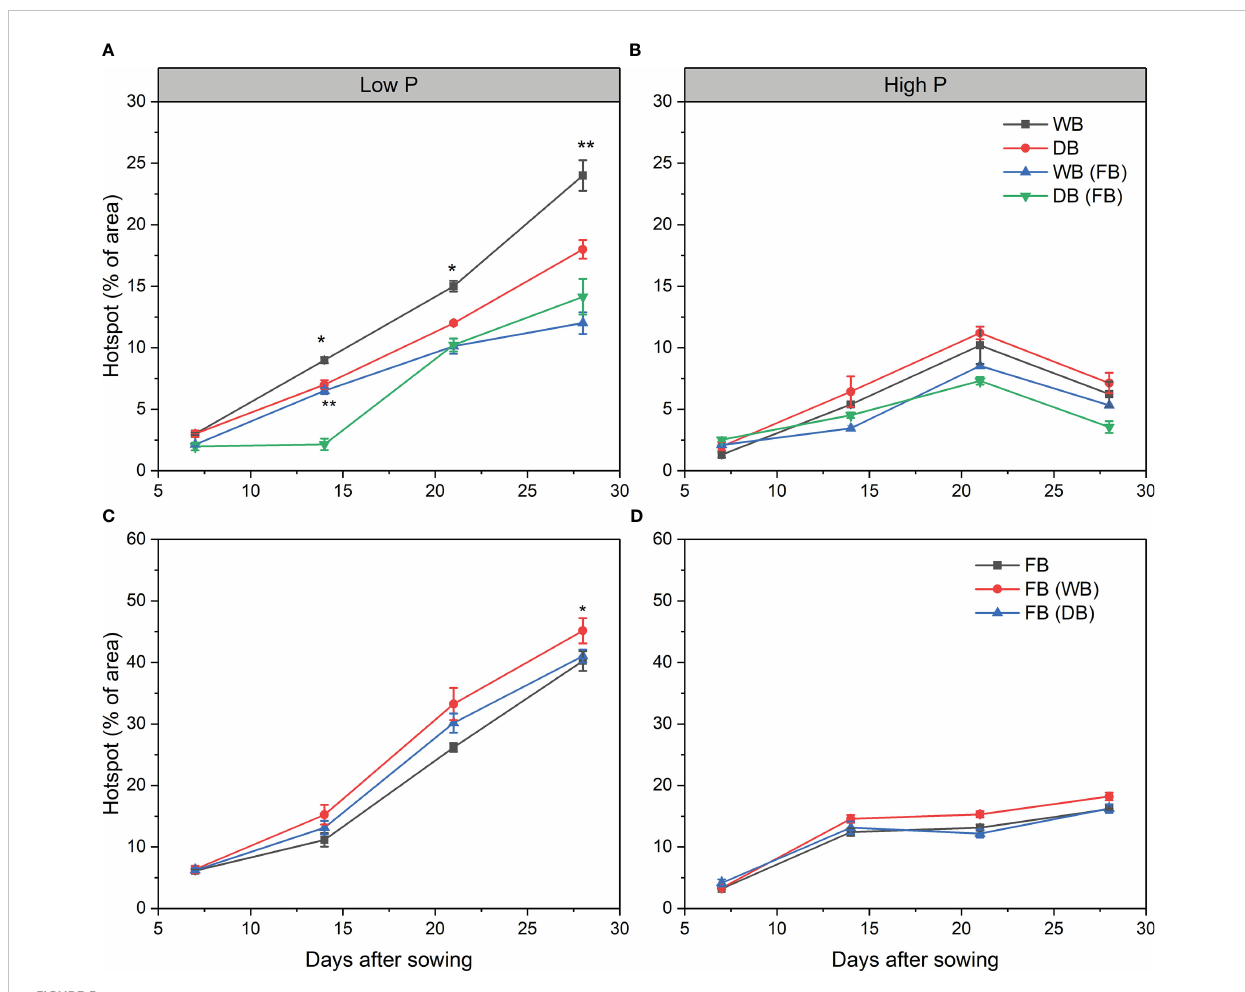
FIGURE 5 Enzymatic hotspot areas of acid phosphatase activities in soil under low (A, C) and high P (B, D) inputs. Signi fi cant differences between two barley genotypes or faba bean grown with them are indicated by asterisks (signi fi cance: * p < 0.05, ** p < 0.01, *** p < 0.001). Signi fi cant differences between sampling times are shown in Supplementary Table 2. FB(WB), faba bean in FB/WB; FB(DB), faba bean in FB/DB; Sole, WB, DB, and FB grown alone; Mix, FB grown with WB and FB grown with